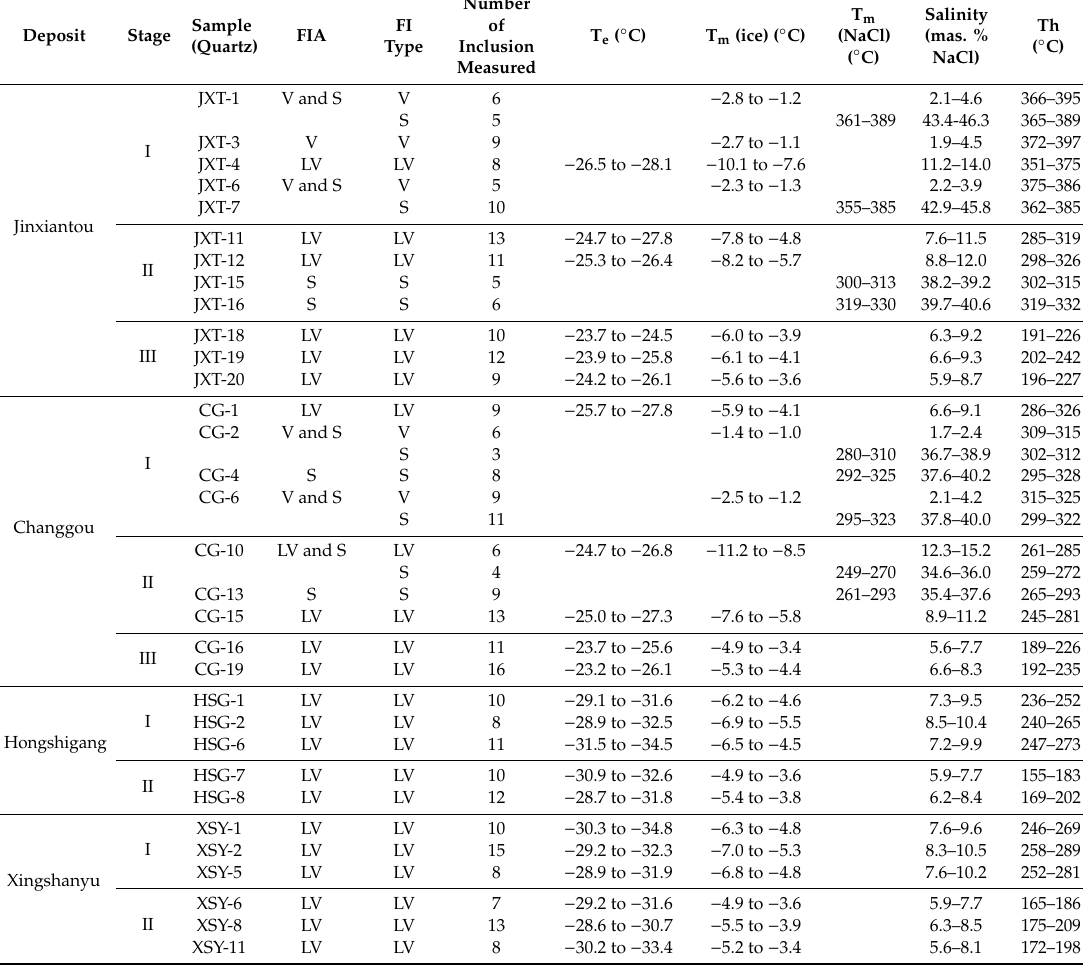
Table1. Microthermometricdataforfluidinclusions(FIs)fromhydrothermalquartzfromtheQibaoshan polymetallic ore